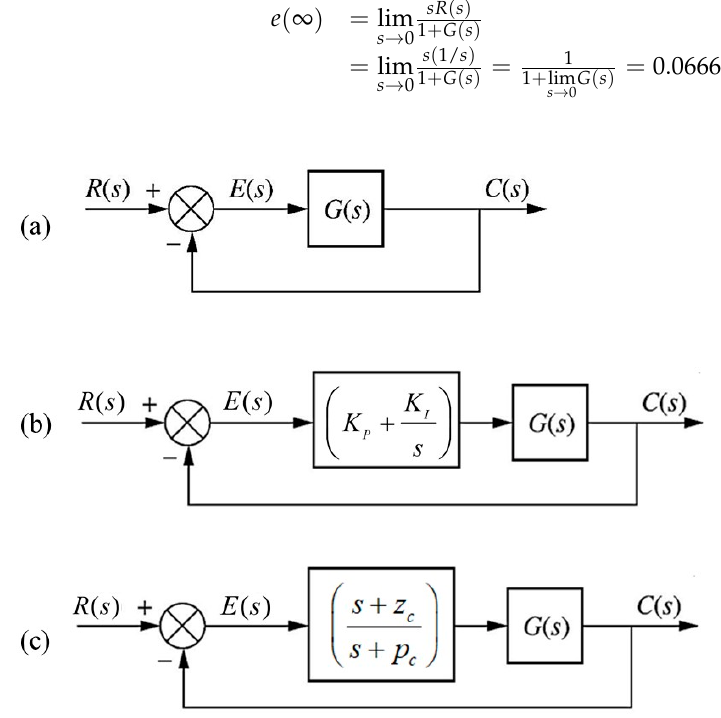
Figure 5. Conceptual diagrams of the unity feedback. ( a ) Unity feedback without the use of any controller. ( b ) Unity feedback using a PI controller. ( c ) Unity feedback using a lag compensator.